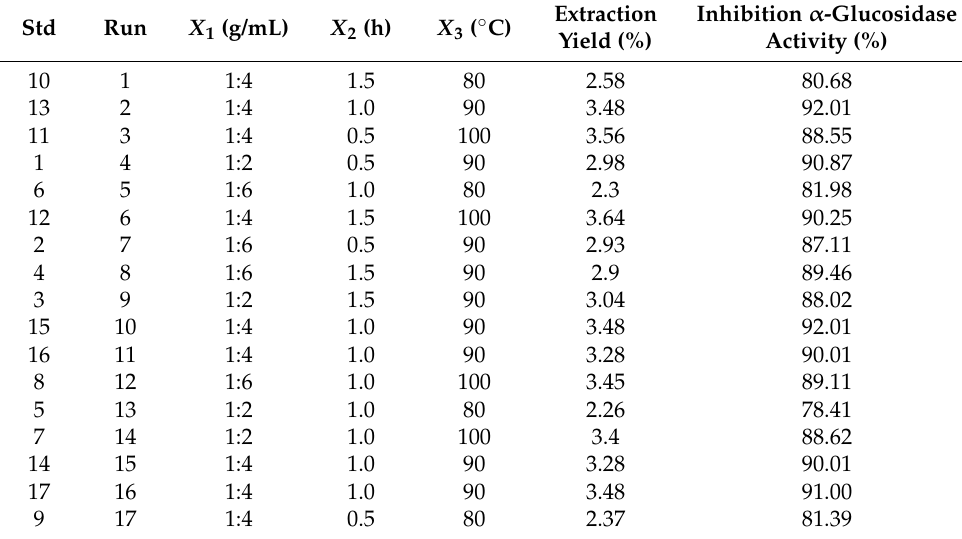
Table 1. Experimental design and results of the Box-Behnken